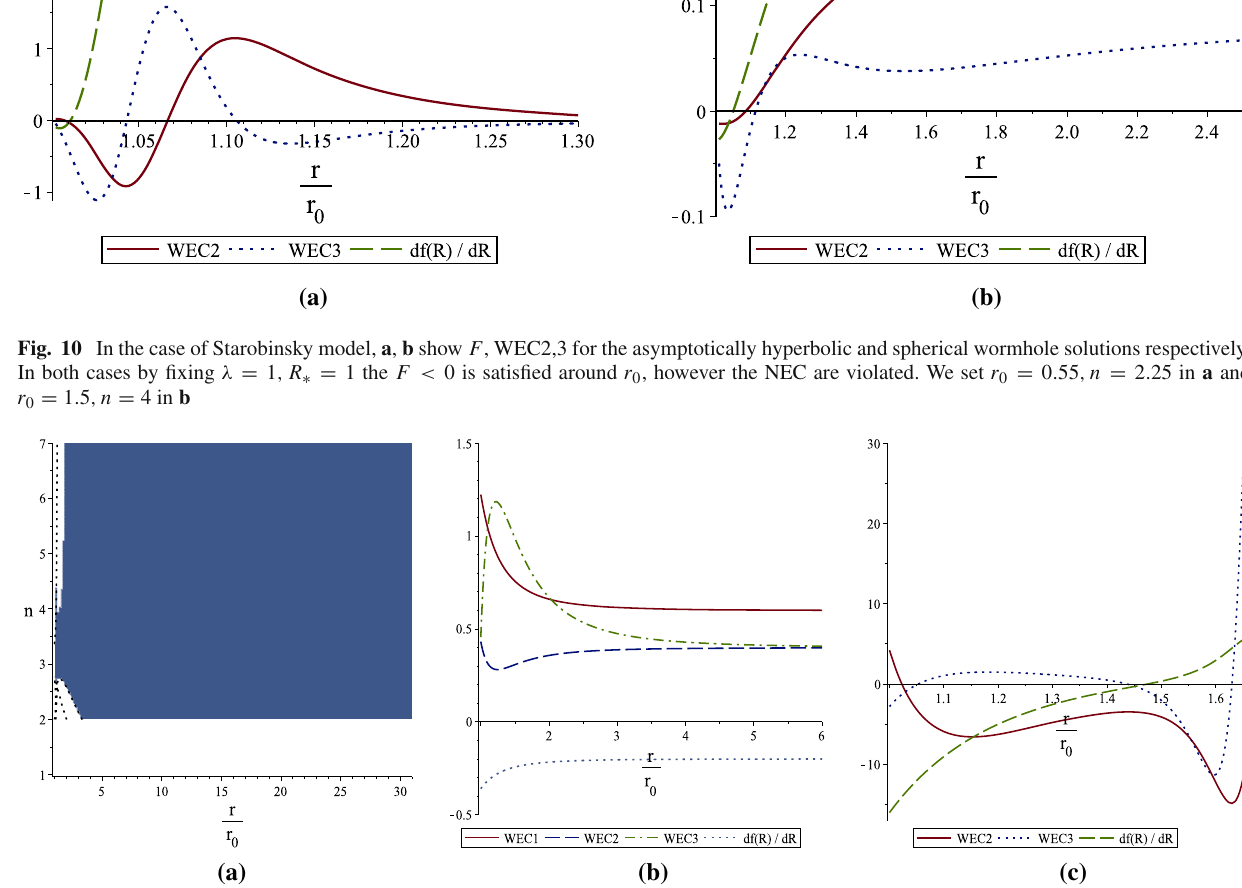
asymptoticly spherical wormholes do not respect the NEC in this back- ground ( c ). In a , b we set a = 2 , b = 20 , c = 20 and r 0 = 1. c Is drawn by setting a = 5 , b = 20 , c = 10 and r 0 = 0 .